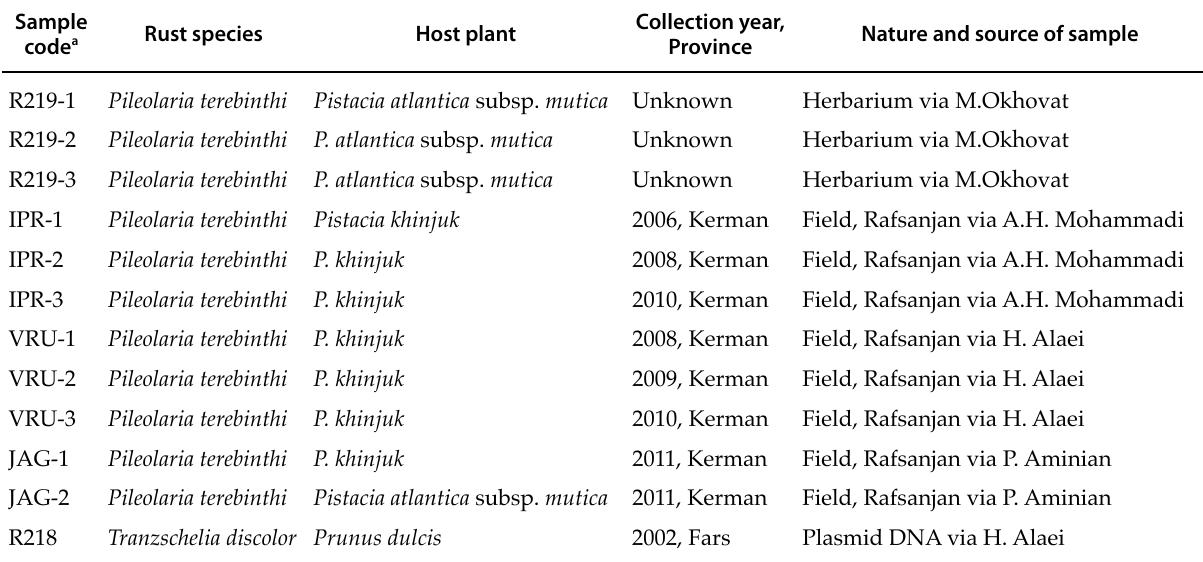
Table 1. Details of rust samples and ITS cloned plasmid DNA used in this study. Sample code